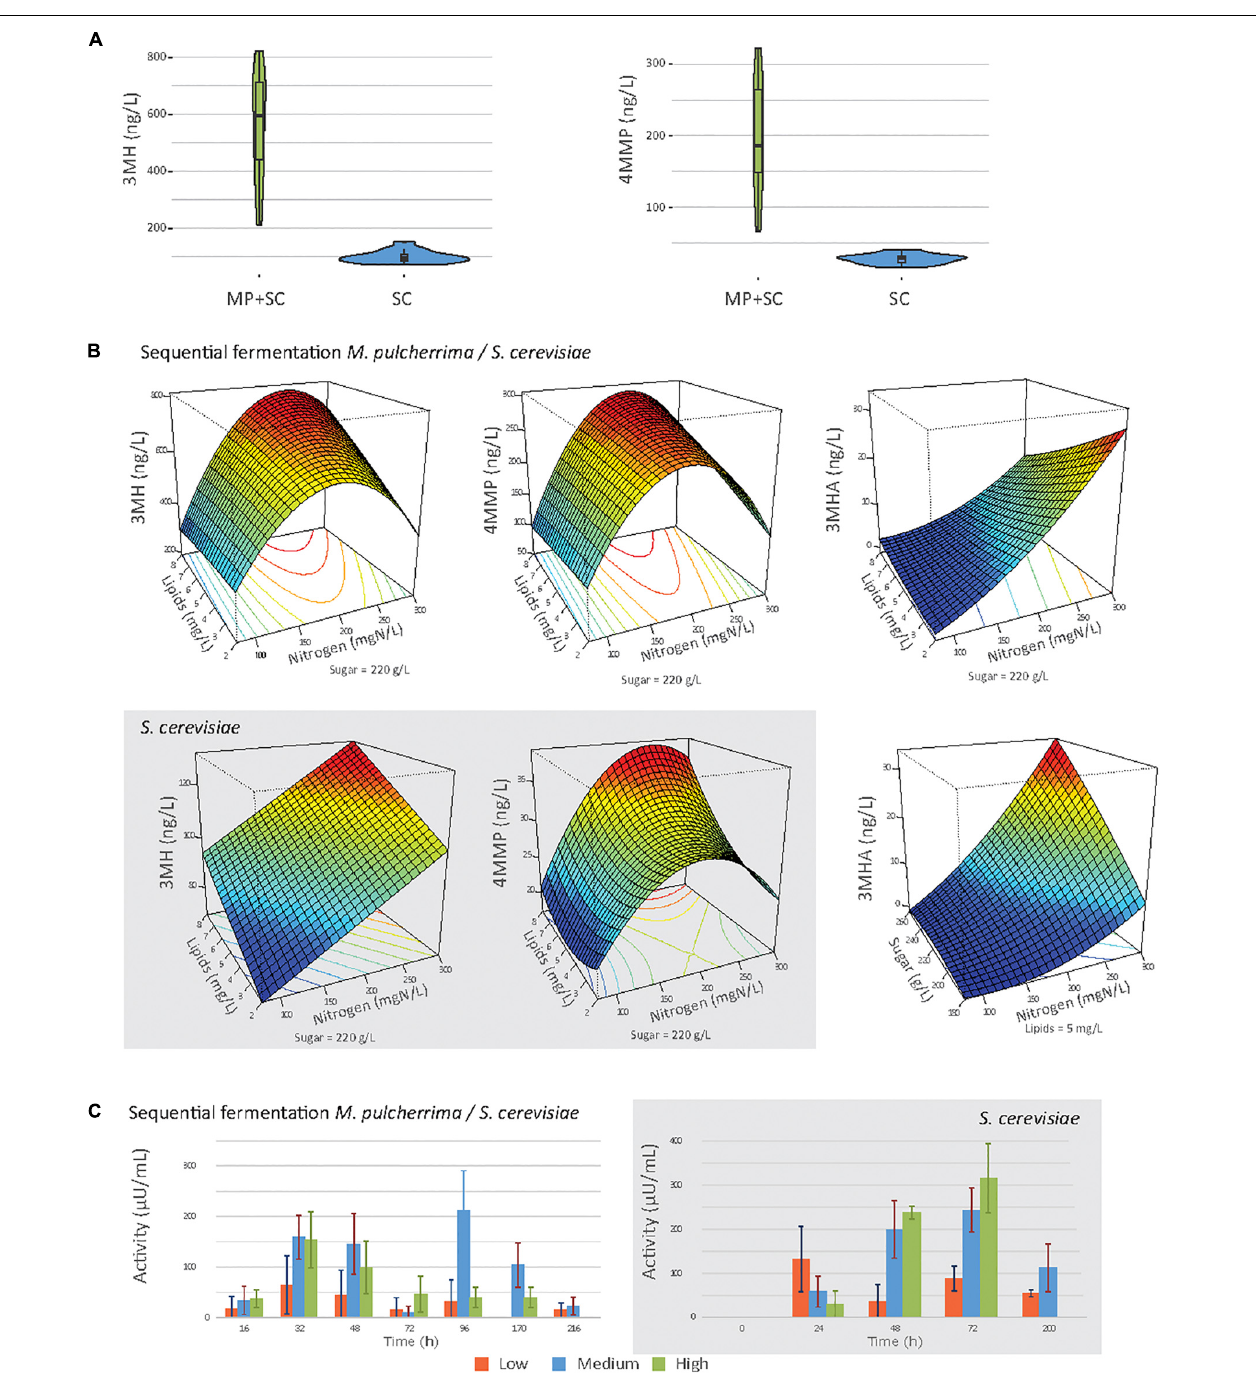
FIGURE 5 | (A) Violin plot of the production of 3MH and 4MMP under sequential inoculation (MP + SC) or in pure culture of S. cerevisiae (SC), at 90% of fermentation progress. (B) Response surfaces of thiol production under sequential inoculation or in pure culture of S. cerevisiae (gray box). (C) Mean β -lyase activity depending on the initial nitrogen concentration during fermentation under sequential inoculation and in pure culture of S. cerevisiae (gray box). 80 mgN/L: orange bars, 190 mN/L: blue bars, and 300 mgN/L: green bars.